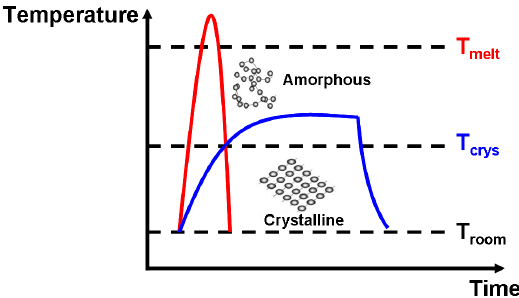
Figure 1. Thermal switching of PCMs between crystalline and amorphous phases.